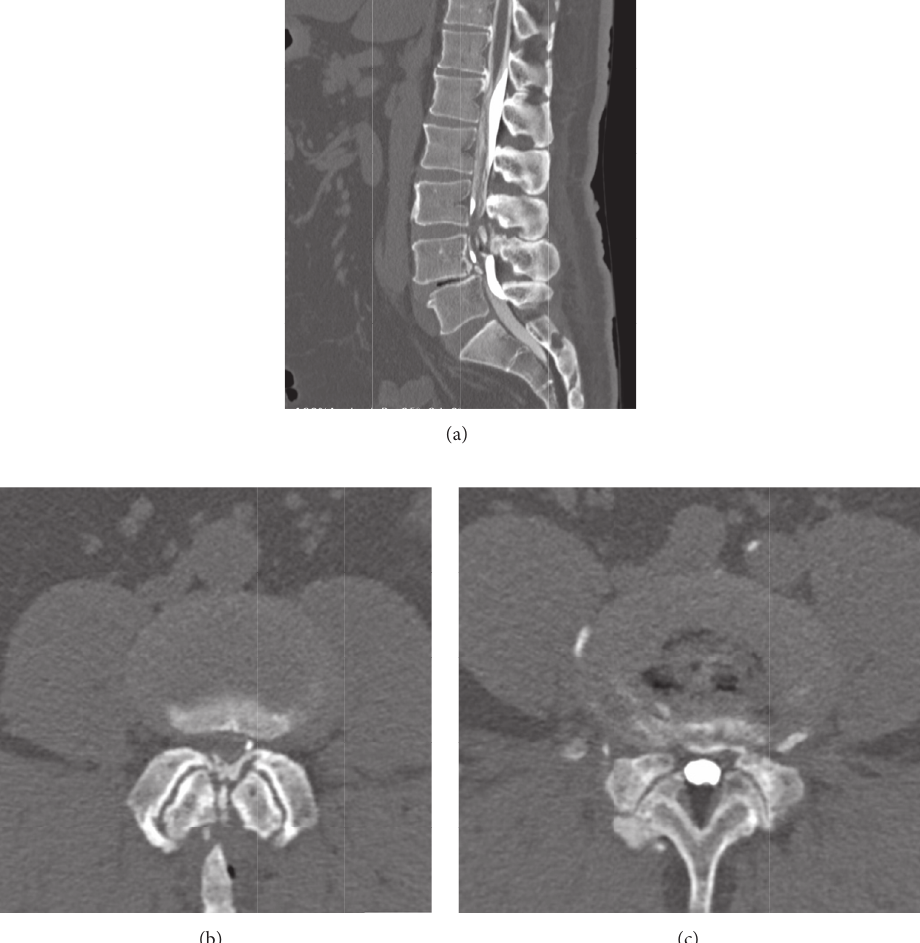
Figure 3: Preoperative computed tomography (CT) myelography. Sagittal image at the midspinal canal (a); axial image at the L3/4 level (b); axial image at the L4/5 level (c). OYL and complete block are seen at the L3/4 level.